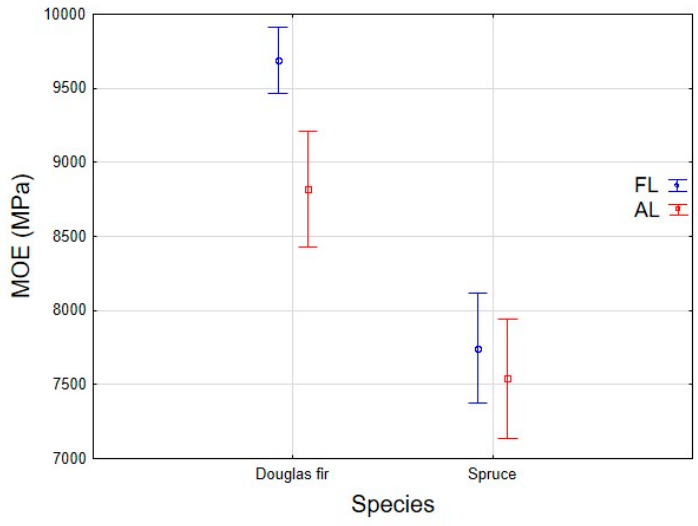
Figure 2. Impact of site on modulus of elasticity.